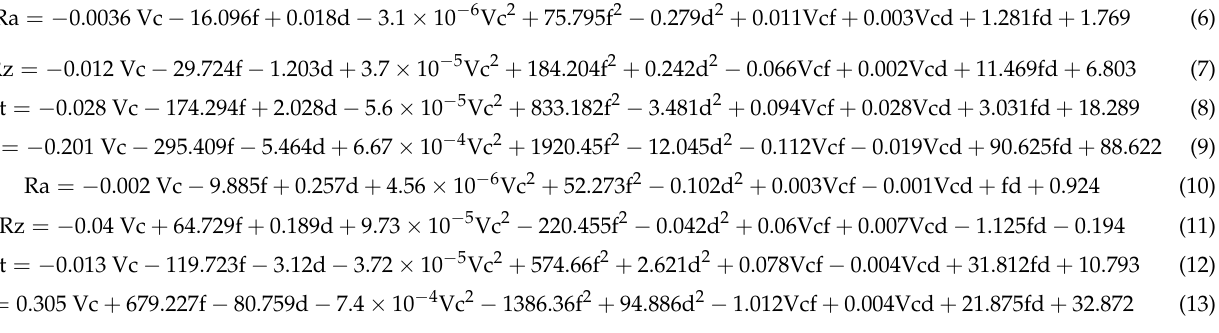
All the developed models (Equation (6) to Equation (13)) of the surface roughness and micro-hardness for the AZ31C magnesium alloy under dry and cryogenic cutting conditions are given